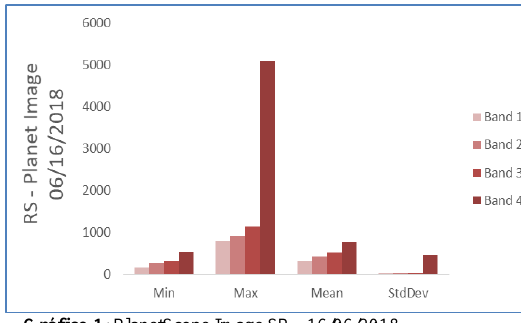
Gráfico 1 : PlanetScope Image SR - 16/06/2018